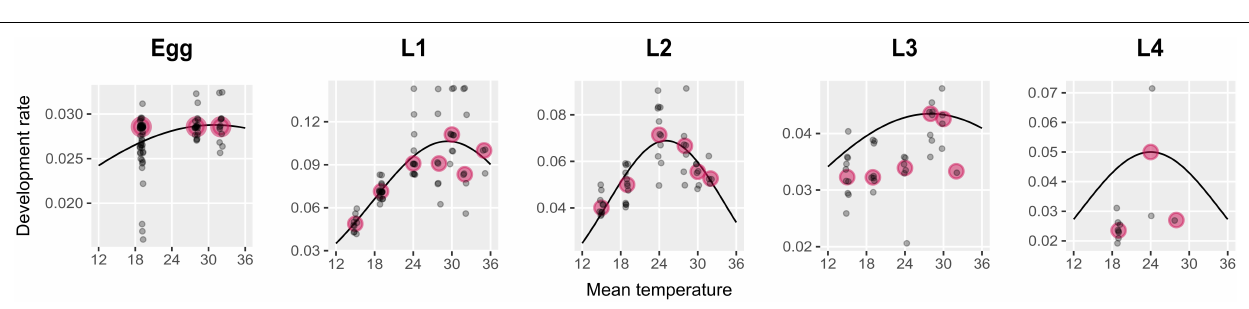
FIGURE 5 | Development rates and thermal performance curves from egg to L4. Gray points represent the mean development rate per colony and are slightly jittered along the x-axis to ease visualization. Pink points indicate the median of development rates among colonies in a